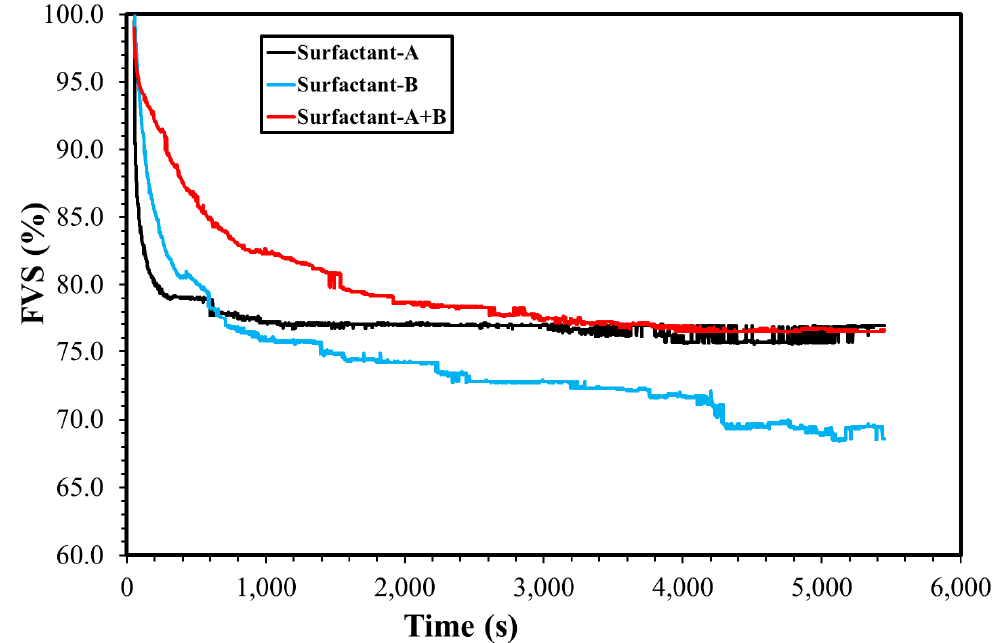
Figure 3. FVS of surfactants using seawater and air as a gas medium at 25 °C .